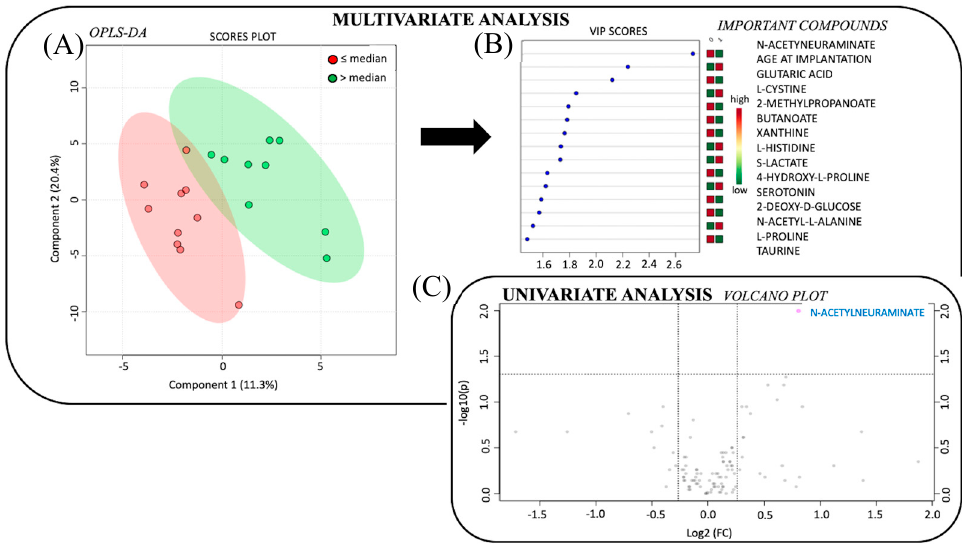
Figure 1. Statistical analysis to compare the metabolome profile from perilymph fluid of cochlear implants (CIs) patients according to duration of hearing loss. ( A ) Multivariate analysis by partial least squares discriminant analysis (PLS-DA), discriminating between patients according to the median duration of hearing loss. The red circles show data for patients with duration of hearing loss ≤ 12